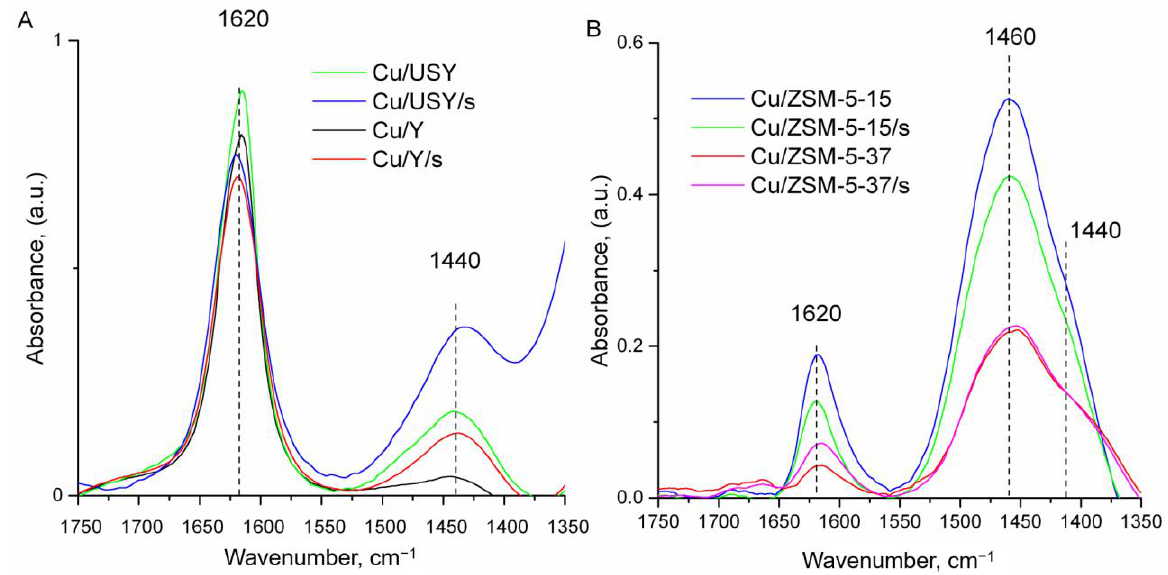
Figure 3. In situ FTIR spectra of zeolite samples with adsorbed NH 3 at room temperature: ( A ) Cu/Y and Cu/USY, ( B ) Cu/ZSM-5-15 Cu/ZSM-5-37.